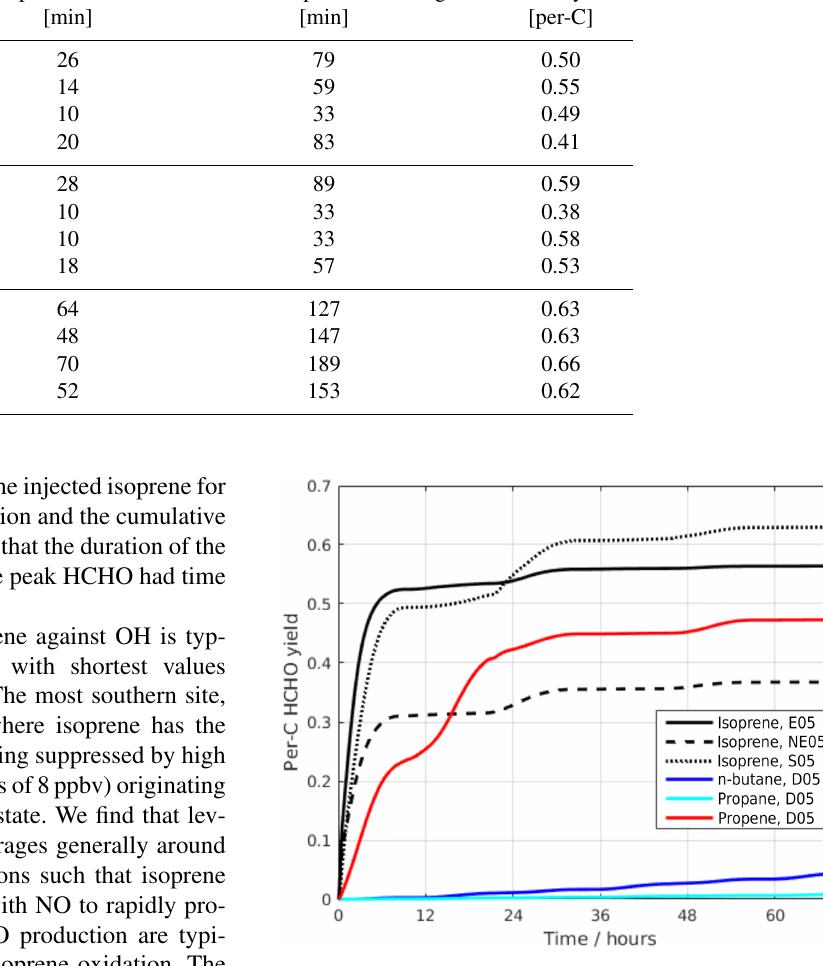
Table 2. Results of the photochemical box modelling for forested region scenarios (Table 1). Scenario